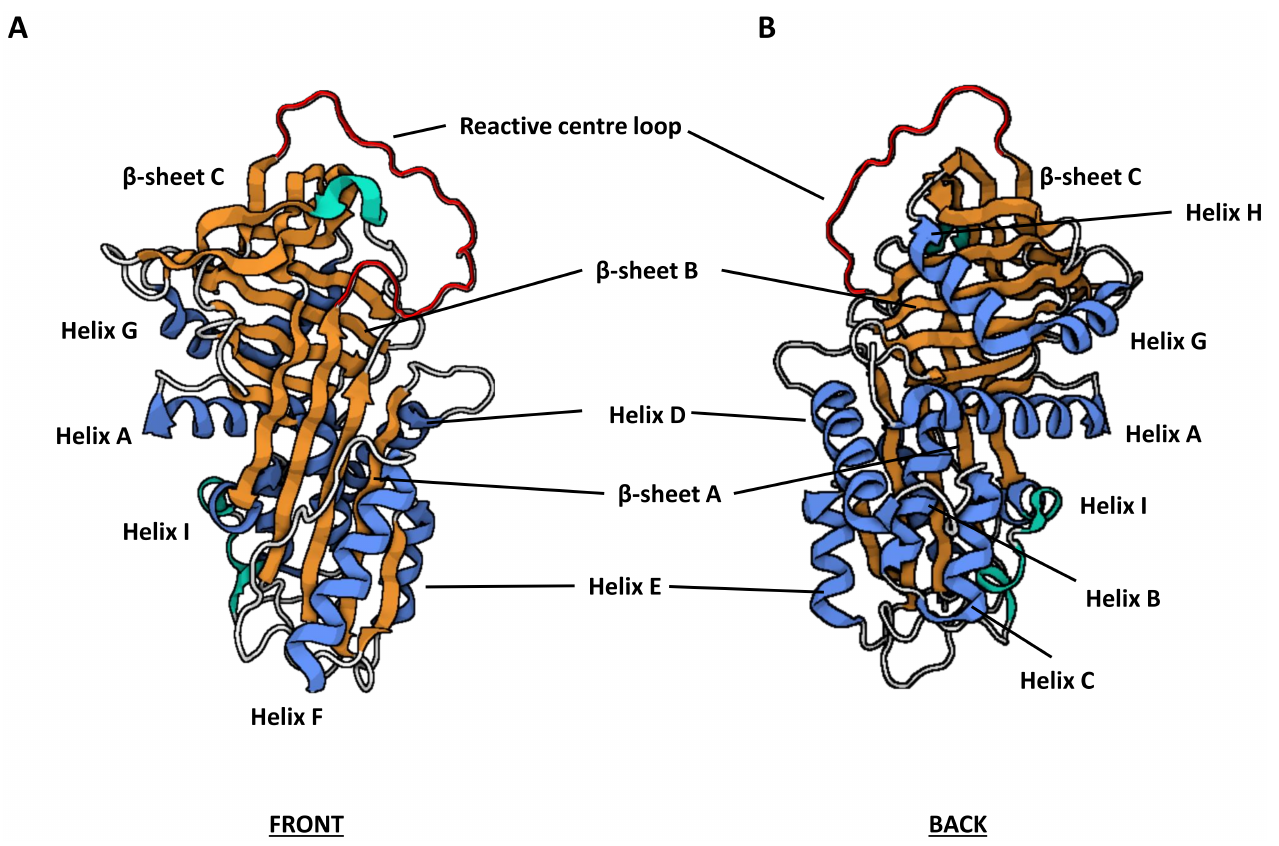
Figure 1. The canonical serpin tertiary structure (PDB code: 1QLP) comprises three β -sheets (orange), seven to nine α -helices (blue) and the reactive centre loop (red) shown in the front ( A ) and back ( B ) orientations. PDB code 1QLP was accessed on 25 March 2021. Created with